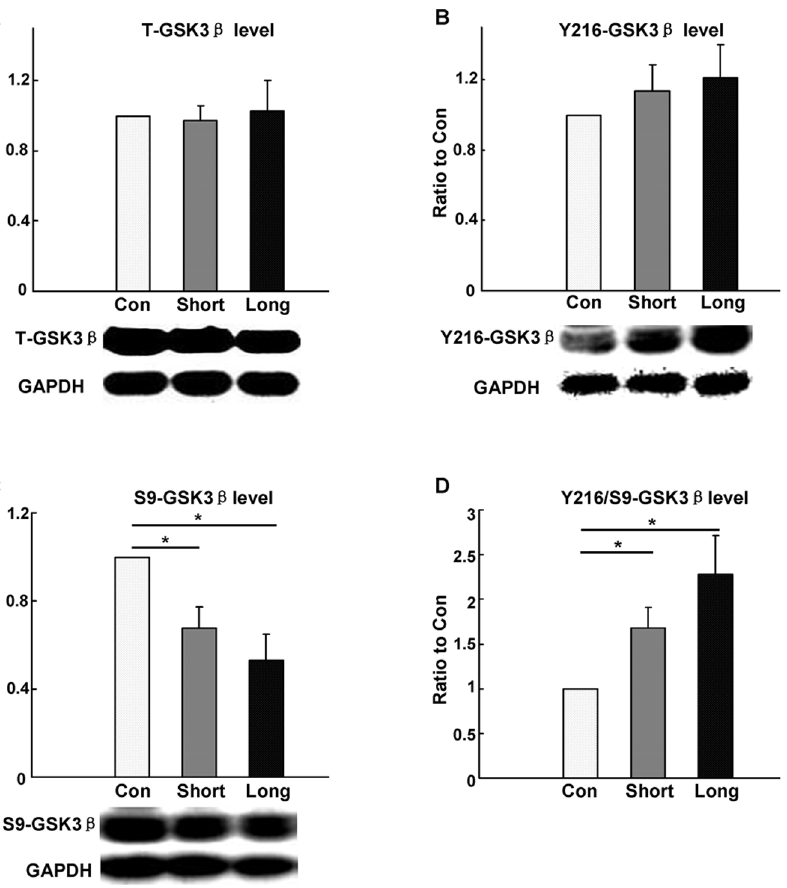
Figure 3. Western blotting analysis of odor exposure on GSK3 b activity in the OB. A: T-GSK3 b expression level was not altered in the three treated groups (n=8, P (C to S) . 0.05; P (C to L) . 0.05). B: Y216-GSK3 b showed an increasing tendency in short-term and long-term enriched odor exposure OBs (n=8, P (C to S) =0.131; P (C to L) =0.214). C: S9-GSK3 b presented a decreasing tendency in the OBs from mice subjected to short-term and long-term enriched odor exposure (n=8, P (C to S) , 0.05; P (C to L) , 0.05). D: Phosphorylation status expressed as the ratio of Y216-GSK3 b to S9- GSK3 b (Y216-GSK3 b /S9-GSK3 b ) significantly up-regulated after short- and long- term odor exposures (P (C to S) , 0.05; P (C to L) , 0.05). C: control; S: short-term; L: long-term. * P , 0.05. The group data shown are the average 6 SEM.